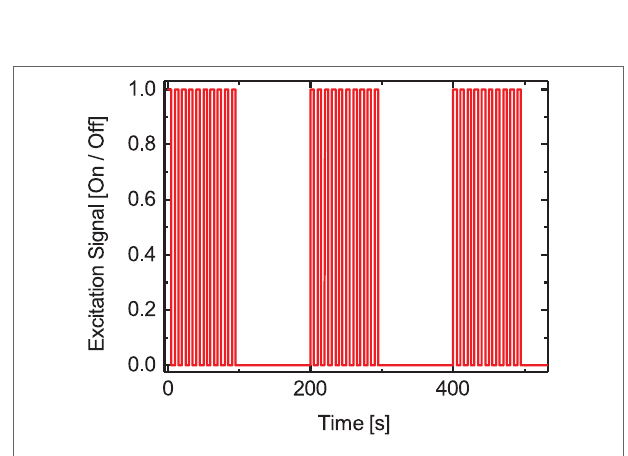
FigURe 9 | Comparison of heat transfer velocities obtained with the amplitude damping method and with the Δ T method for several measurement conditions in the Heidelberg Aeolotron. The agreement of both methods is excellent with a deviation of (0.3 ± 0.5%). The measurement uncertainties of the Δ T method are slightly larger than those of the amplitude damping method; however, the measurements are faster by a factor of 6–12 depending on the exact measurement condition.